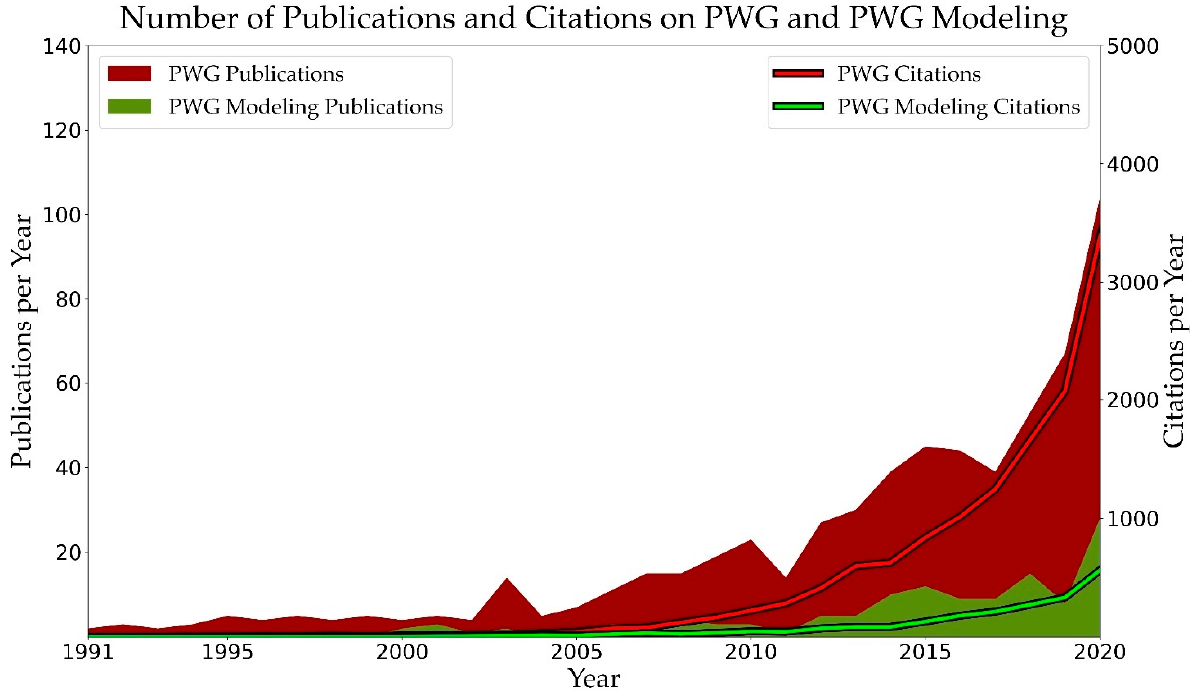
Figure 3. Increased number of publications and citations related to the PWG and modeling of PWG (extracted from [16]).